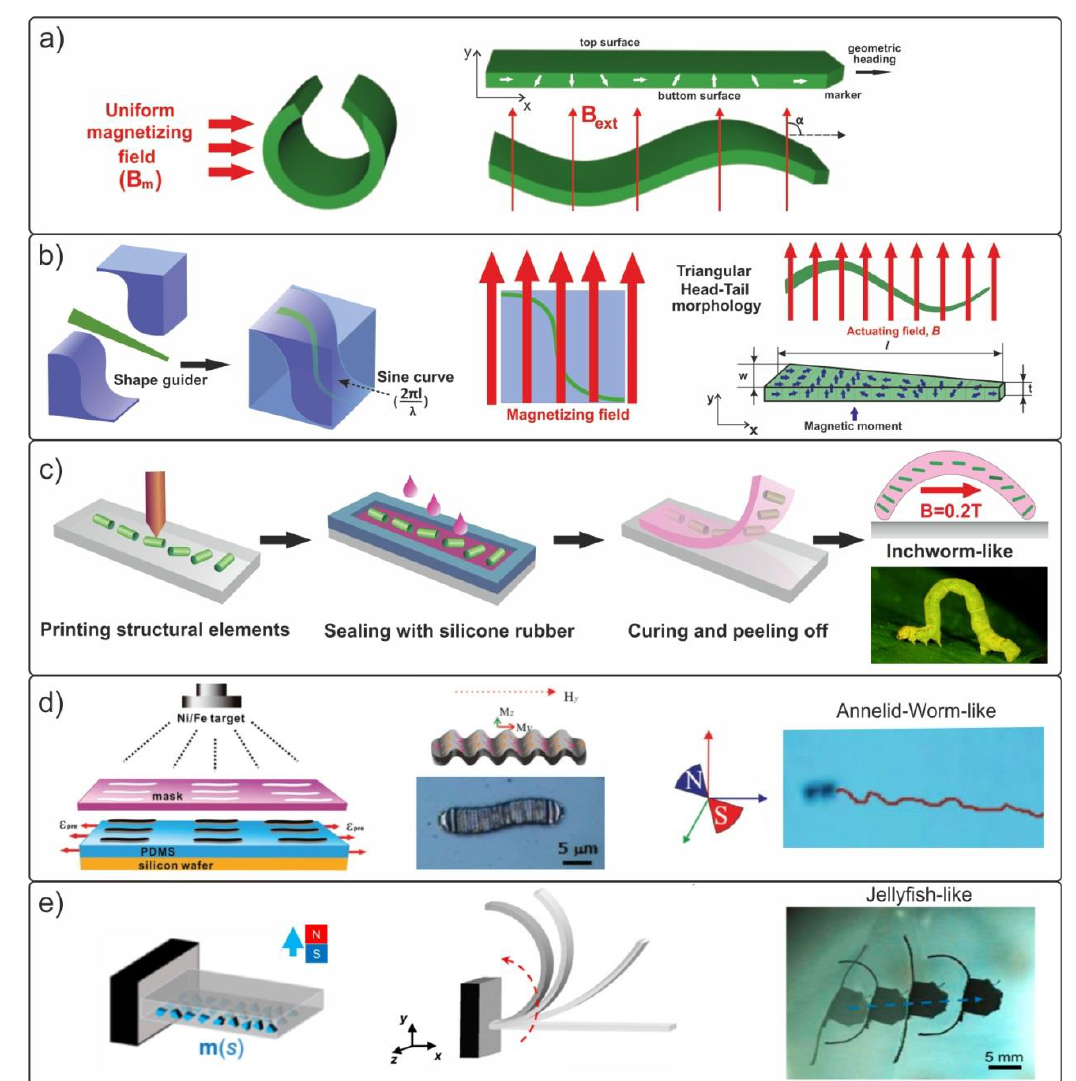
Figure 3. ( a ) Schematic representation of the programming method for the magnetic structure and the resultant sinusoidal magnetization profile of the designed millimeter-sized swimmer. ( b ) Procedure of magnetization along a preset profile in the shape guider and control of a triangular silicone swimmer by an external magnetic field. ( c ) The process of formation of inchworm millimeter-sized magnetic robots using a 3D printer with fused deposition modeling and molding in silicone. ( d ) Schematic representation of the manufacturing process of a magnetic annelid-worm-like microswimmer and its propulsion in a magnetic field [78]. ( e ) Schematic representation of the beam bending under the action of an external magnetic field and the movement of the millimeter-sized swimmer in water, simulating the movement of a jellyfish [108].